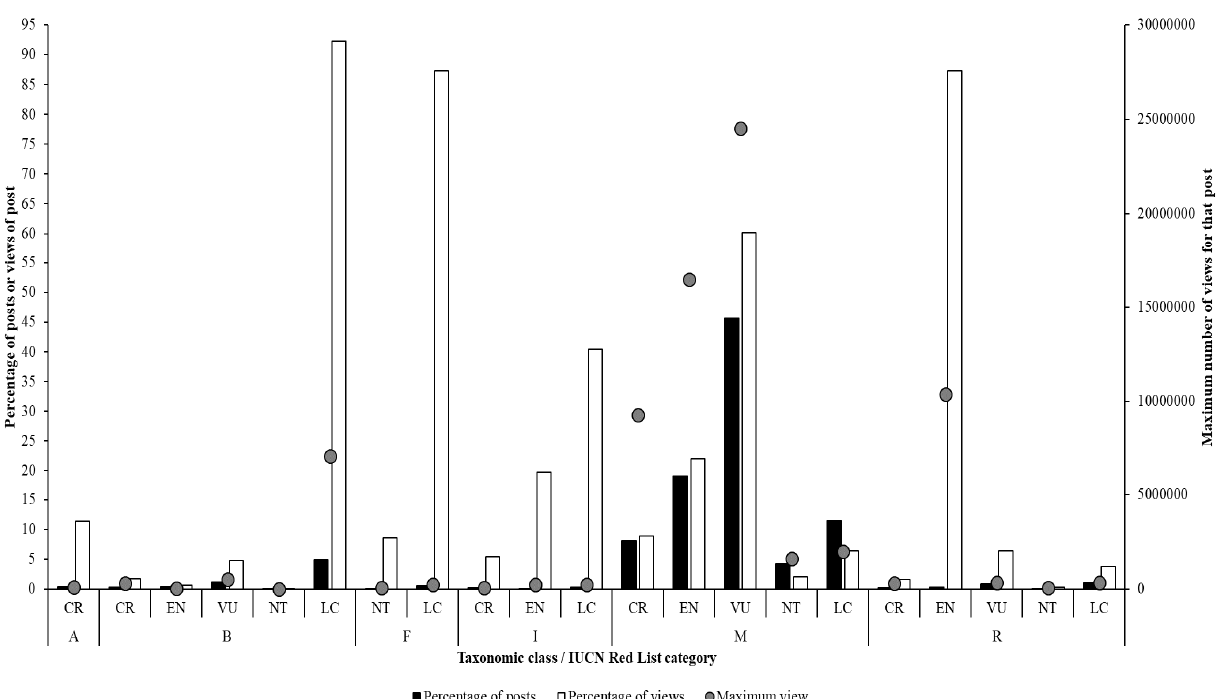
Figure 3. Conservation status of content, the percentage of posts on taxa with an IUCN threat level across all 20 zoos compared to the views of that post (as a percentage of all views for all posts featuring that class) against the maximum number of views for a post focusing on a species of that taxonomic class (A = Amphibian, B = Bird, F = Fish, I = Invertebrate, M = Mammal, R = Reptile) with an IUCN threat category (CR = Critically Endangered, EN = Endangered, VU = Vulnerable, NT = Near Threatened, LC = Least Concern).